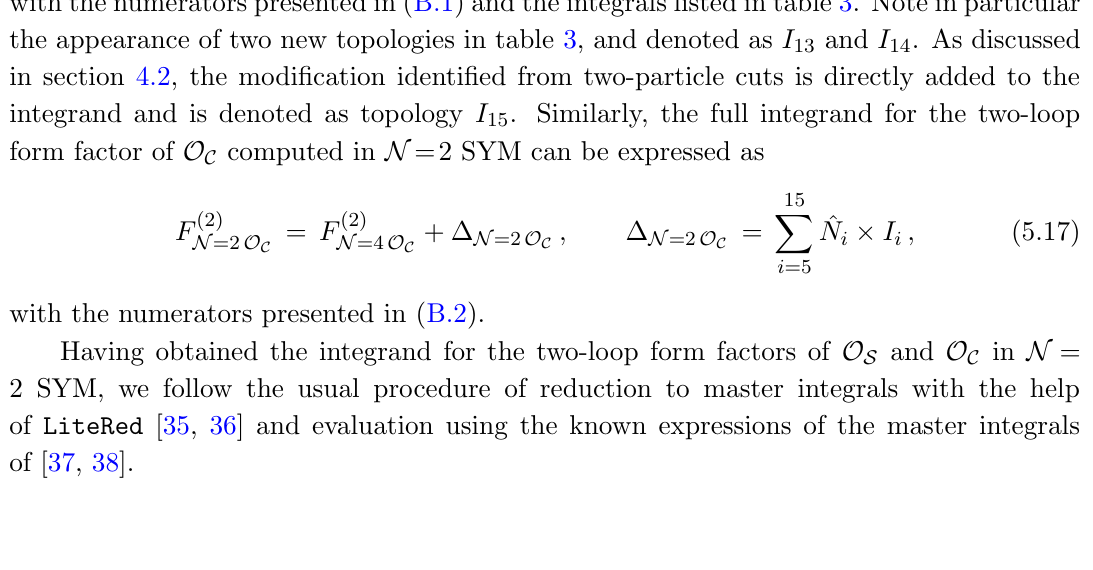
(1 + ; 2 + ; 3 + ; q ) in N < 4 O S ; O C